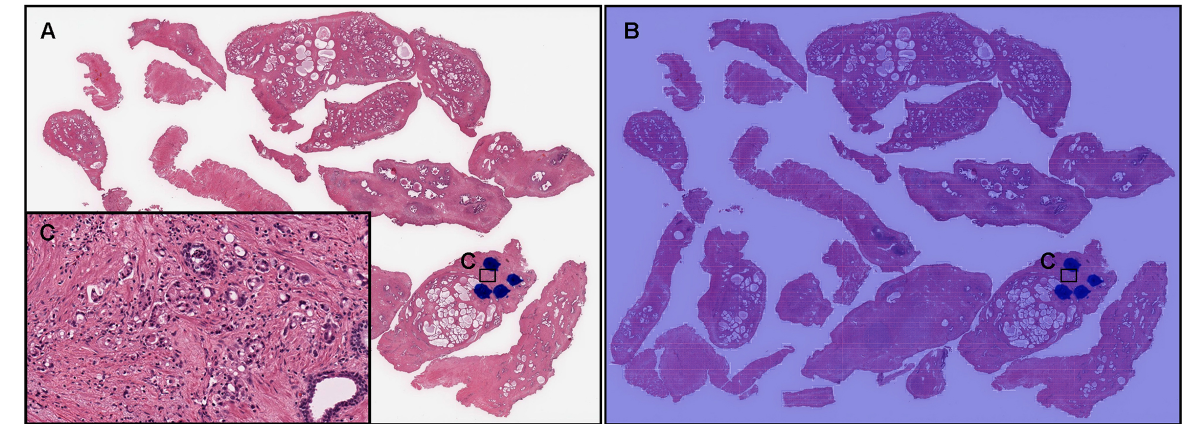
Figure 8. A representative example of prostate adenocarcinoma false negative prediction outputs on a whole-slide image (WSI) from the transurethral resection of the prostate (TUR-P) test sets using the model (TL-colon poorly ADC-2 ( × 20, 512)). According to the histopathological diagnostic report, this case ( A ) has a very small number of adenocarcinoma foci (cells) in ( C ) where pathologists marked surrounding with blue-dots but not in other areas that consist of nodular hyperplasia. The heatmap image ( B ) exhibited no positive adenocarcinoma prediction ( C ). The heatmap uses the jet color map where blue indicates low probability and red indicates high